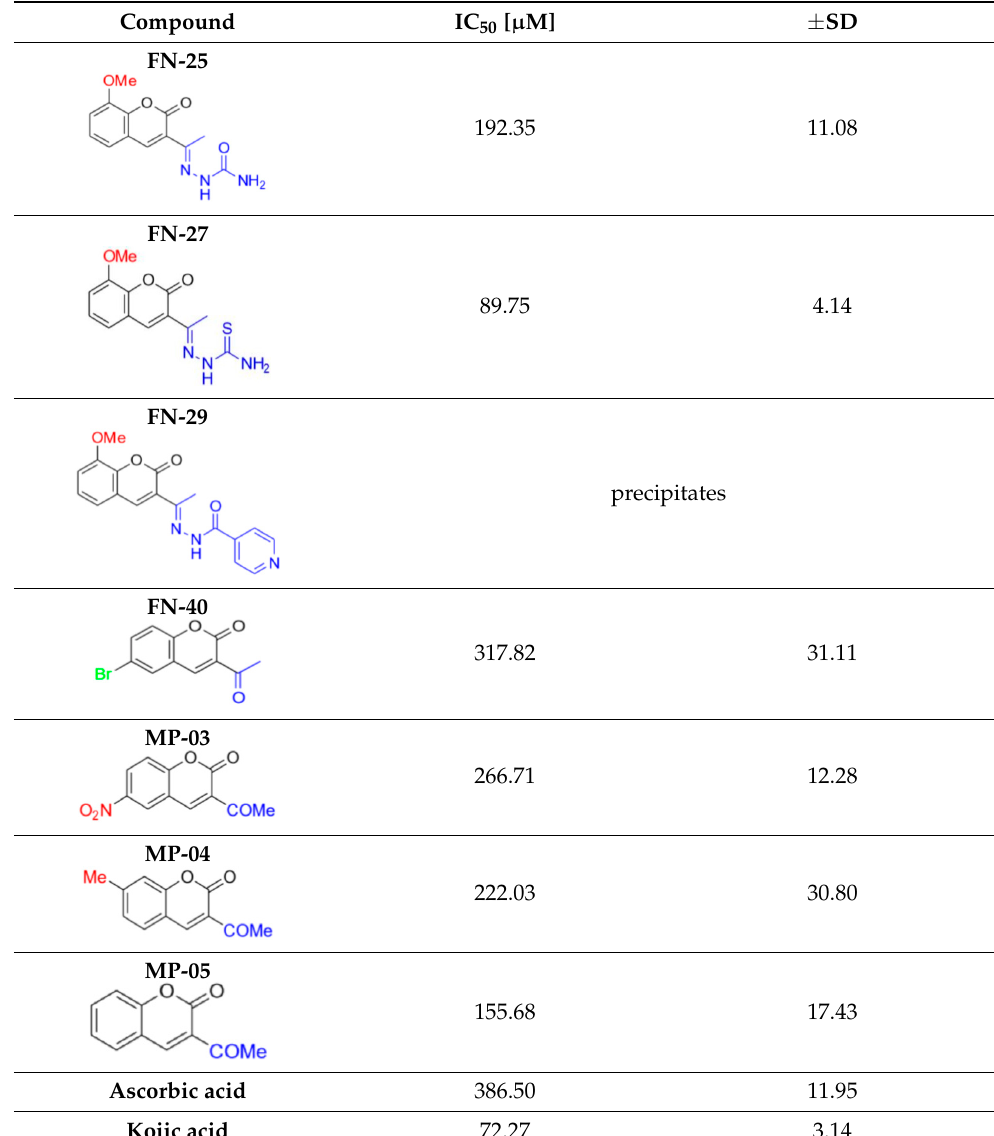
Table 1. Inhibitory activity of coumarin-based compounds on mushroom